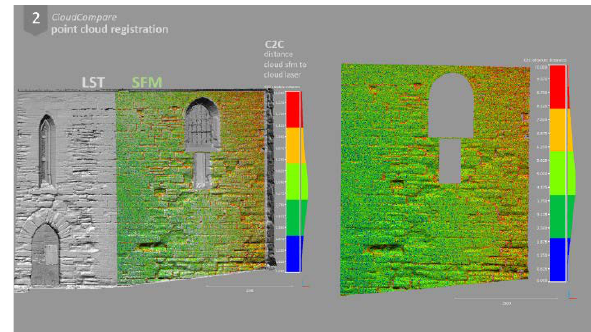
Figure 7. Map of deviation between photogrammetric cloud and scanner